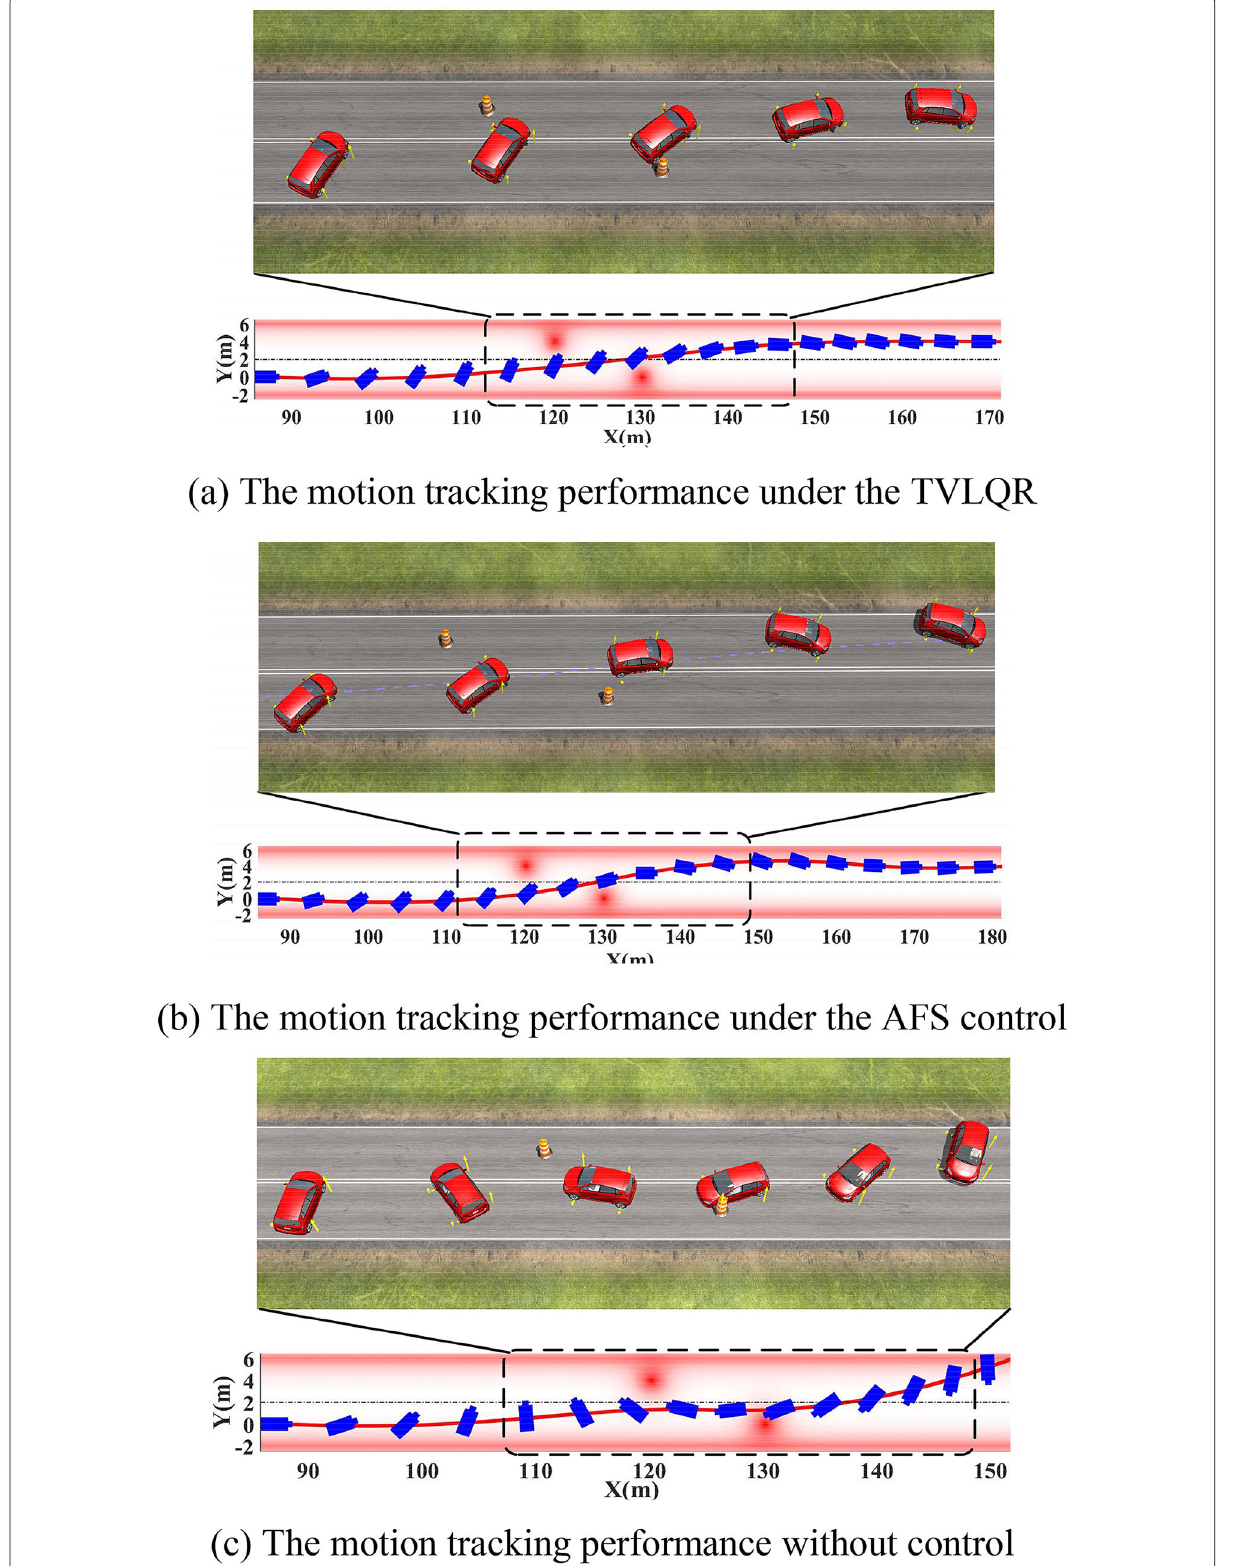
Figure 10 (See legend on previous